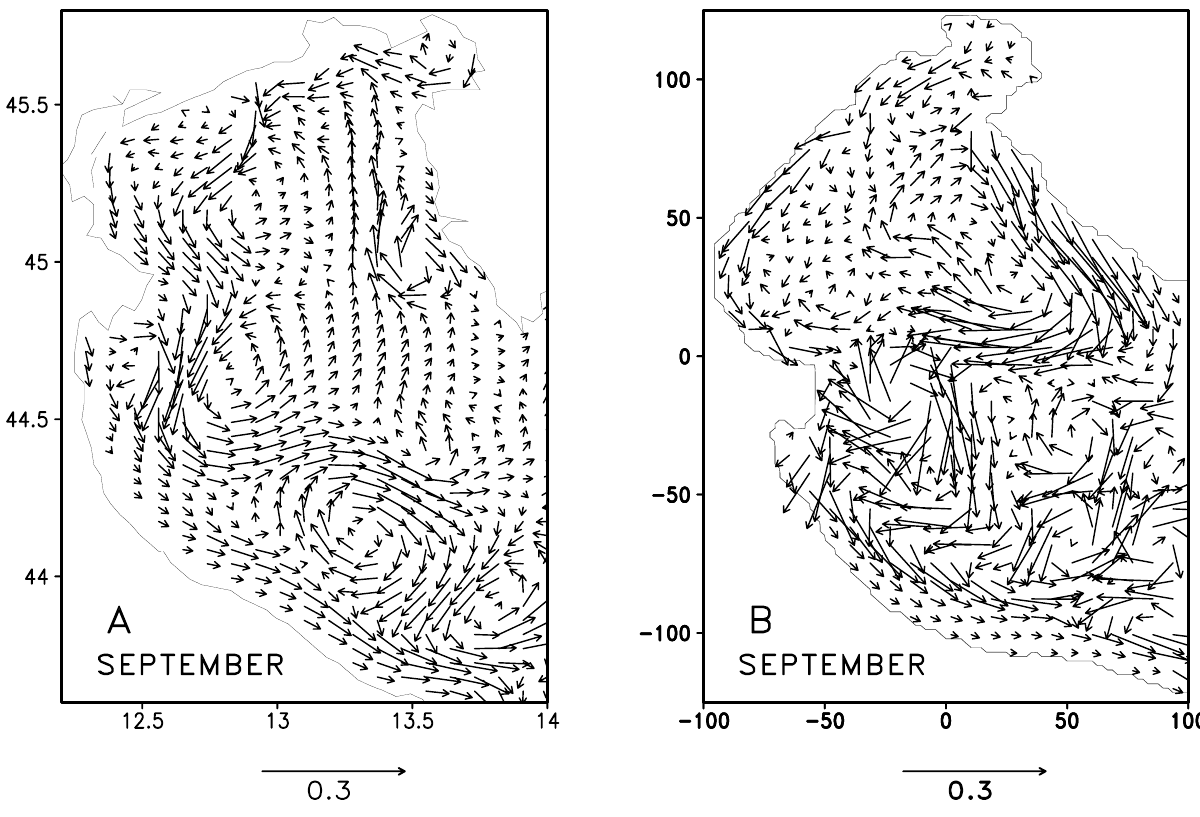
Fig. 16. Northern Adriatic Shelf Model (NASM) 2m depth September circulation compared with the corresponding AIM simulation. (A) : AIM, (B) : NASM. Units are m/s. Not all grid points are